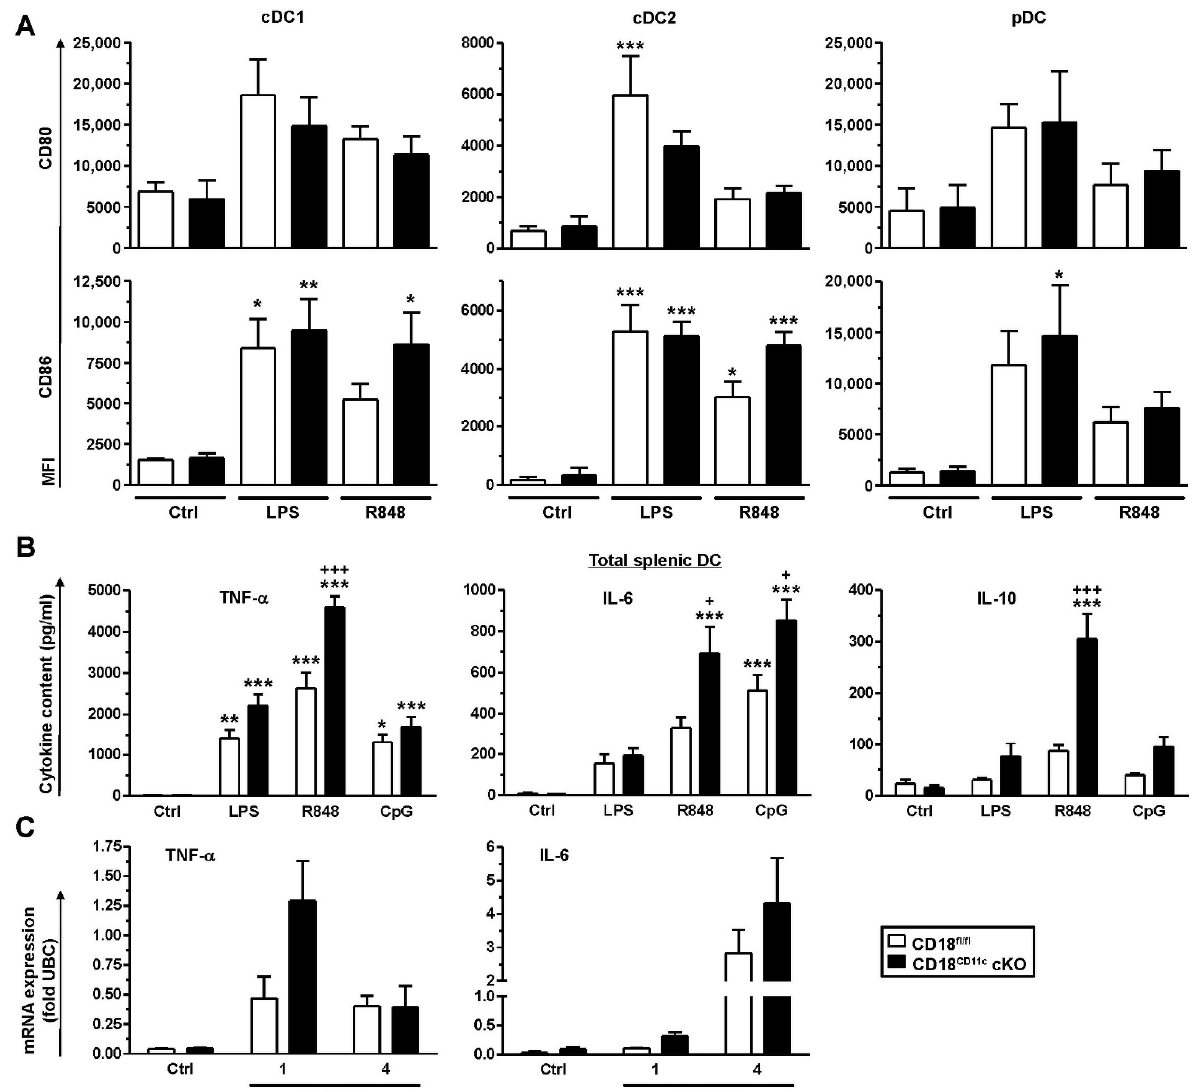
Figure 2. Downregulation of β 2 integrins in splenic DCs results in overexpression of cytokines in response to stimulation. ( A ) Spleen cells were stimulated in parallel with LPS (100 ng/mL) and R848 (1 µg/mL) or left untreated (Ctrl). On the next day, expression of activation markers was assessed by flow cytometry (cDC1: XCR1 + ; cDC2: CD172a + ; pDC: CD317 + ). Data denote the mean ± SEM of 4 experiments. ( B ) Immunomagnetically isolated splenic DCs were seeded into 96-well plates (10 5 /100 µL) and differentially stimulated (CpG: 250 ng/mL). On the following day, supernatants were retrieved for cytokine detection (mean ± SEM of 5 experiments). ( C ) Immunomagnetically sorted splenic DCs were stimulated with R848 for the indicated periods of time. mRNA levels were detected by real-time PCR and are given as fold of expression of the housekeeping gene ubiquitin C (UBC). Data denote the mean ± SEM of 3–4 experiments. ( A,B ) Statistical differences versus * CD18 fl/fl (Ctrl) and + CD18 fl/fl under same conditions are indicated (one-way ANOVA, Tukey test). * ,+ p < 0.05, ** p < 0.01, *** ,+++ p